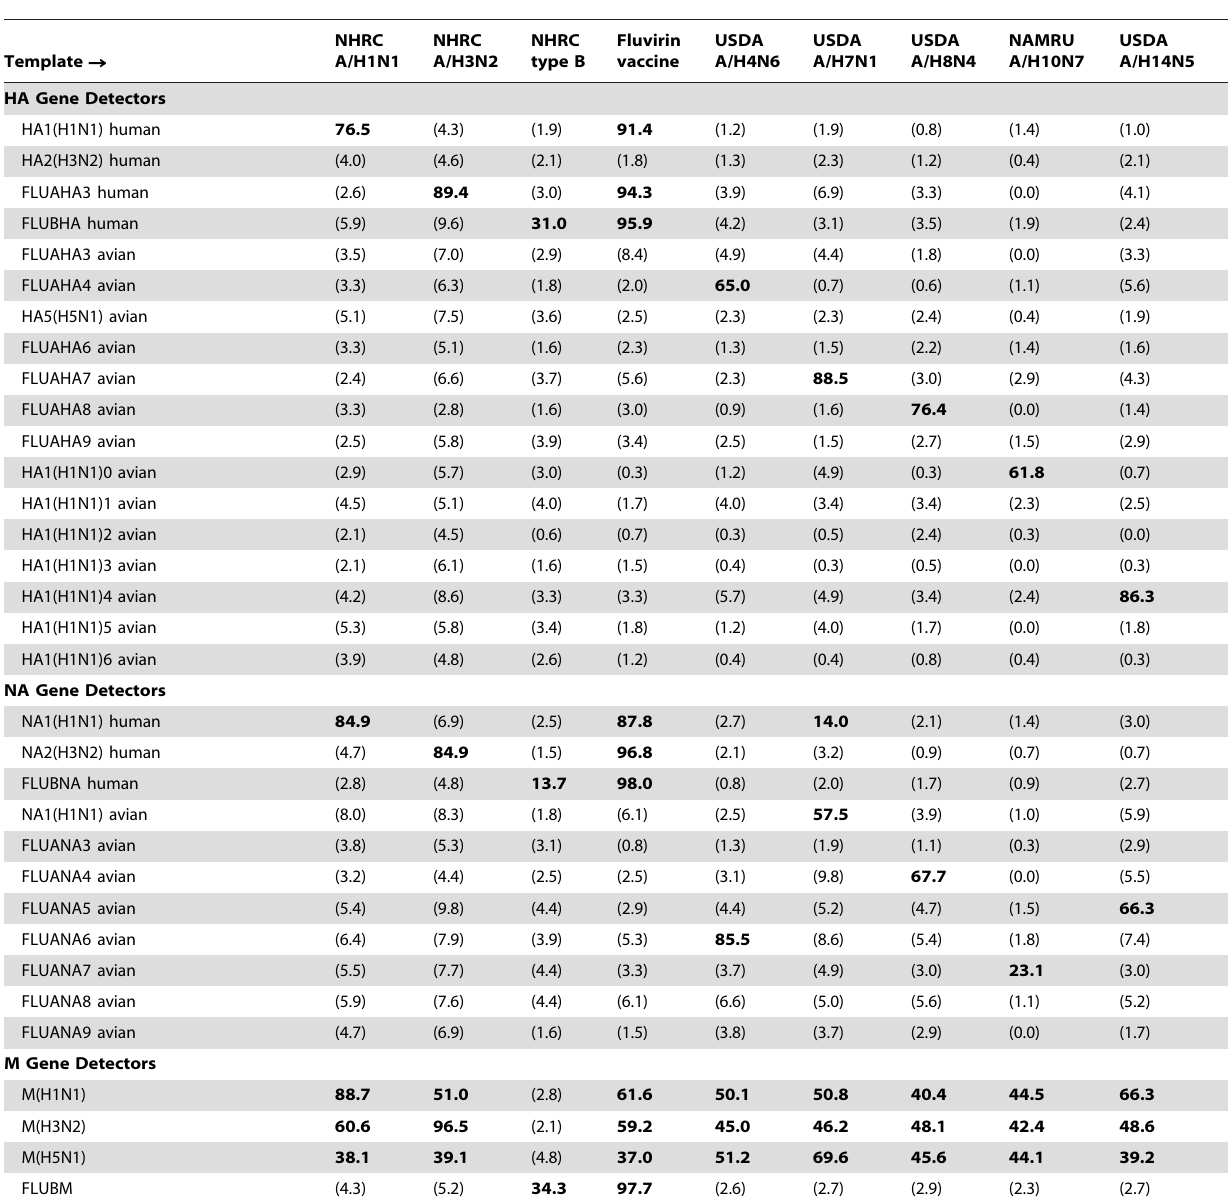
Table 2. Detection of specific HA, NA and M gene sequences from individual type A influenza virus reference strains or trivalent vaccine mixture of reference